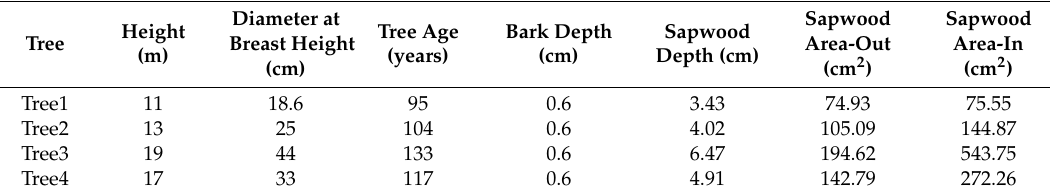
Table 1. Parameters of the four measured